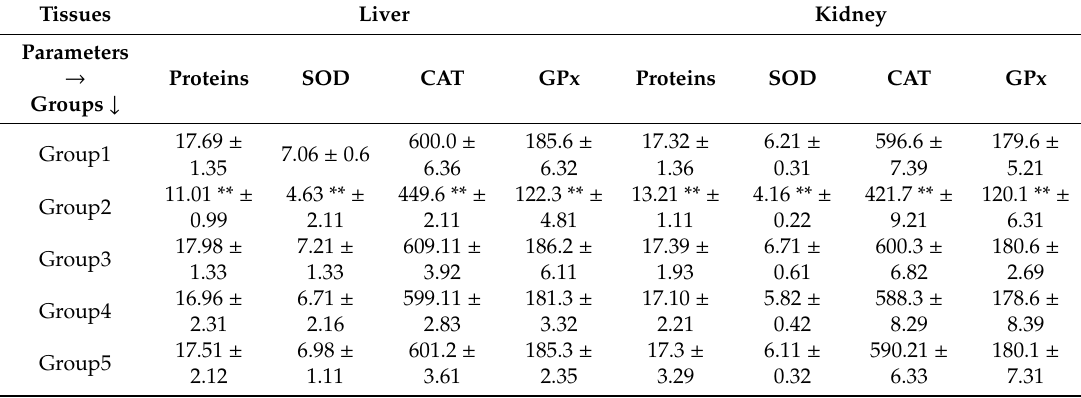
Table 3. E ff ect of Nano-CUR on total proteins and the activities of antioxidant enzymes in liver and kidney of TZ-treated